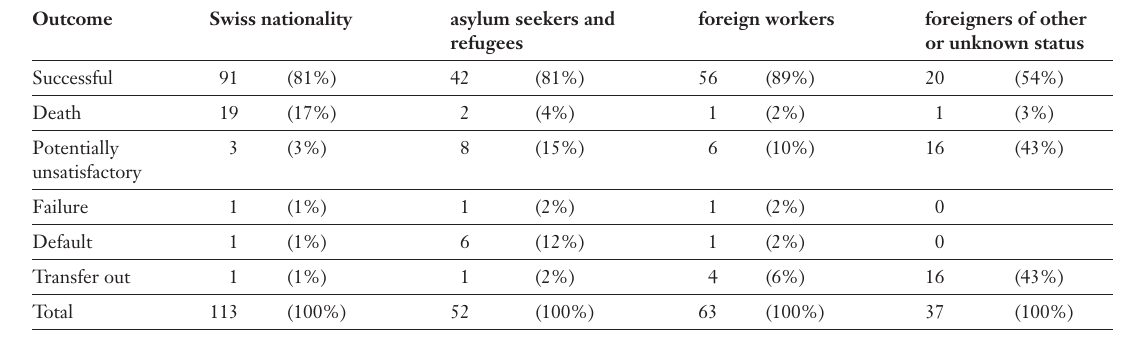
Treatment outcome and legal status.